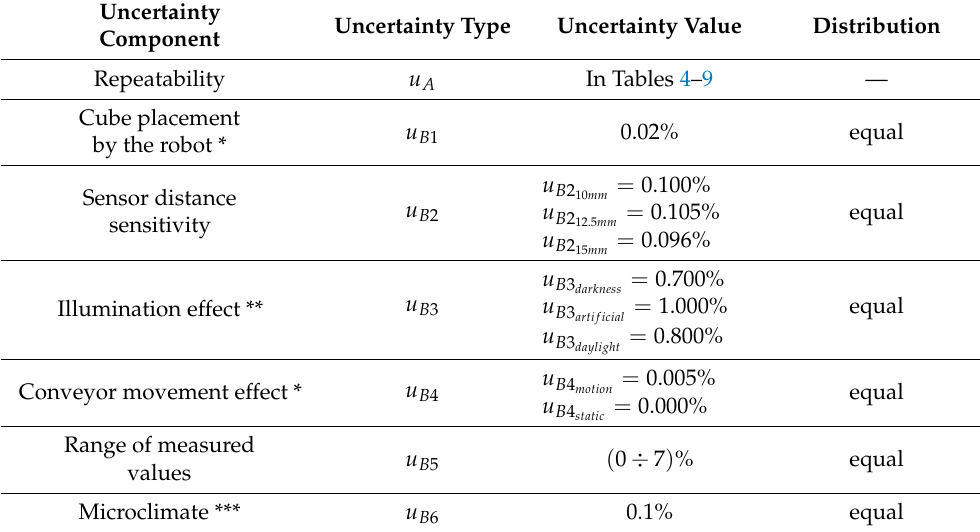
Table 10. Type B uncertainty